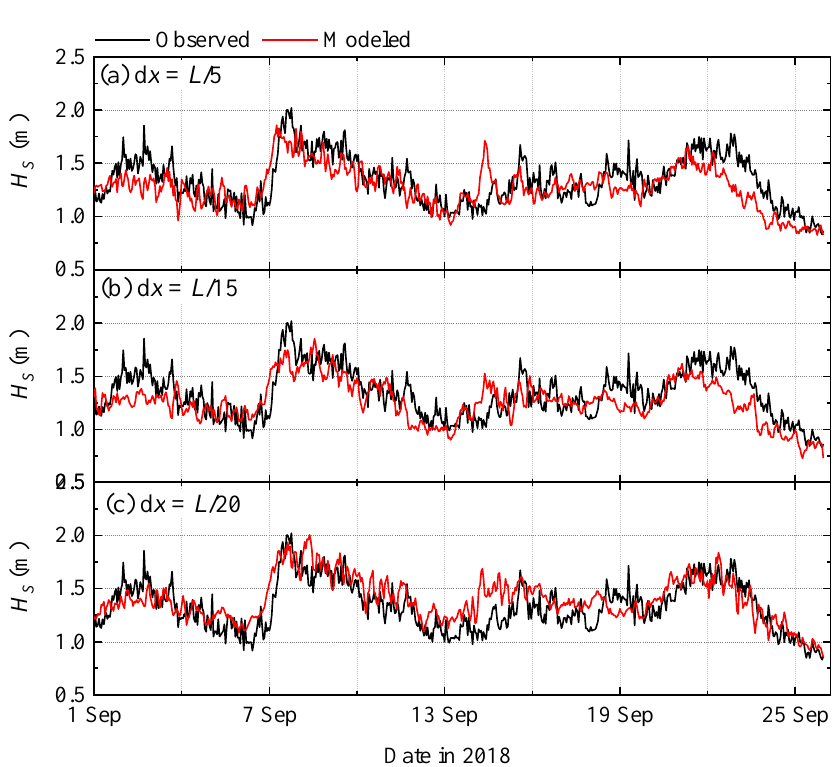
Figure A1. Modeled (red) and observed (black) H S 1–25 September 2018, at the location of sensor G1: ( a ) dx = L /5, ( b ) dx = L /15, and ( c ) dx = L /20.